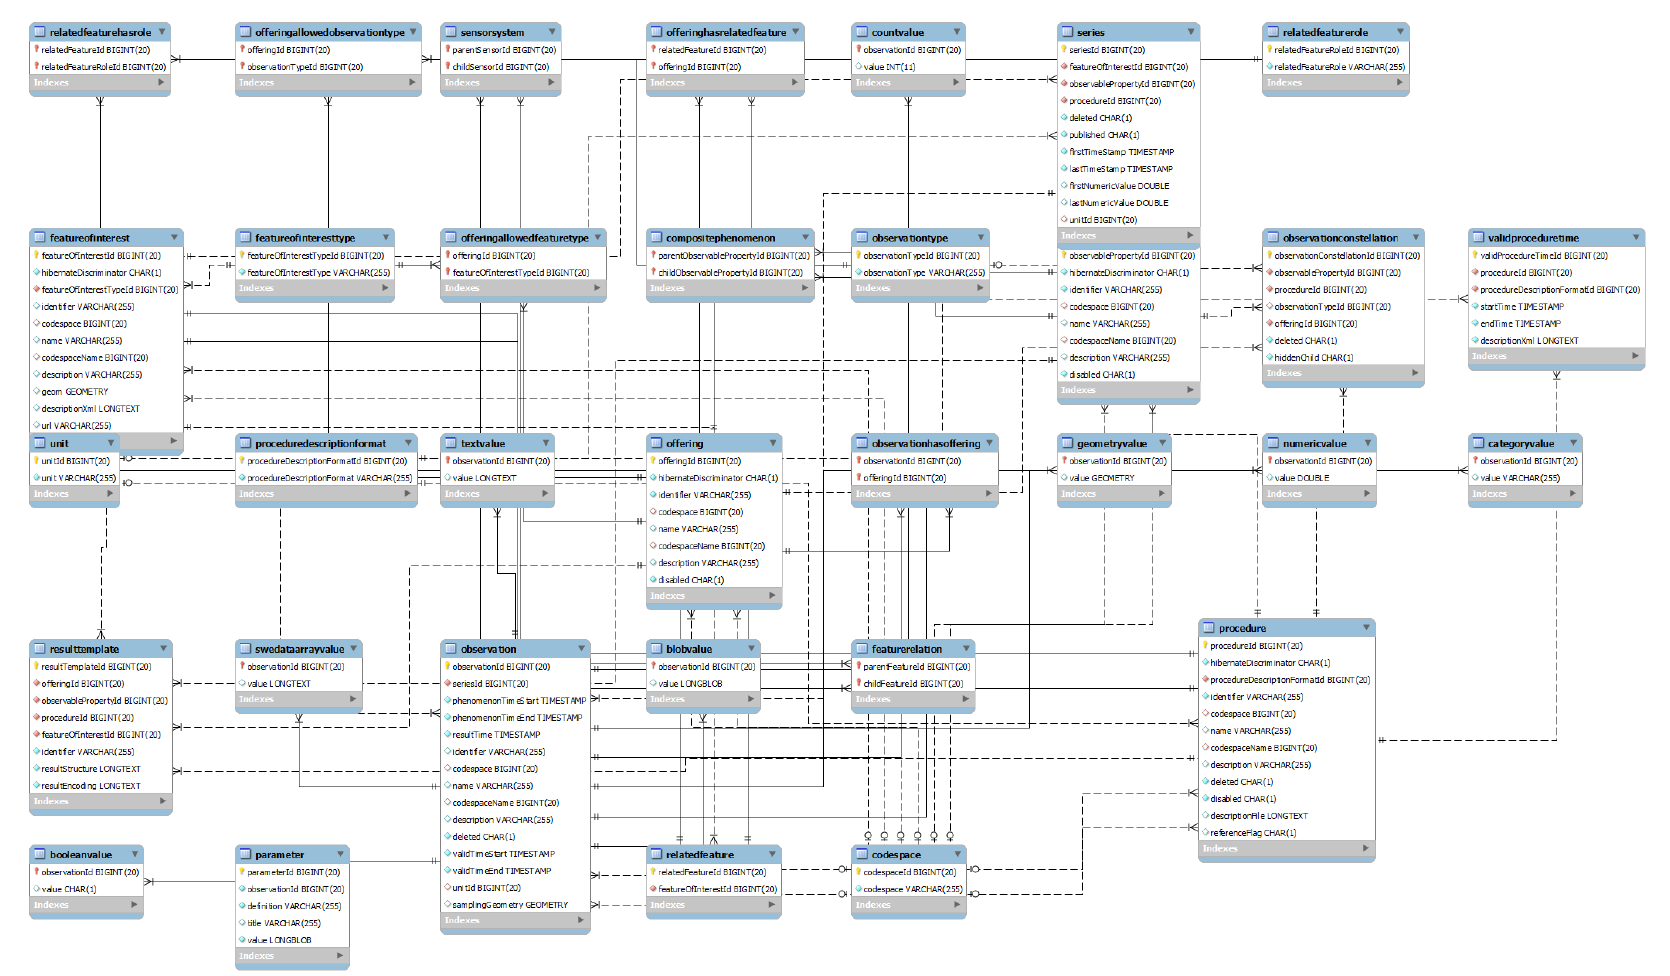
Figure 14. The 52 ◦ North SOS